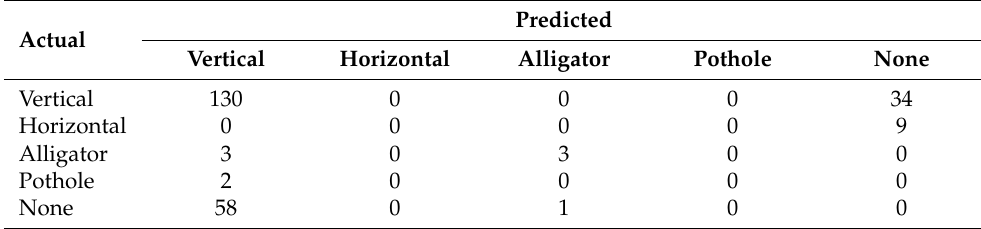
Table 2. Confusion matrix of Model